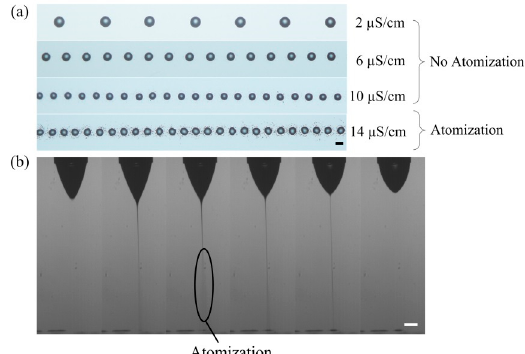
Figure 4. The atomization in e-jet printing: ( a ) the image of printed droplets on a silicon wafer; ( b ) the jetting process for liquid with a conductivity of 14 µS/cm. The time interval between adjacent images was 143 µs. The viscosity of the liquids was 60 mPa·s. The applied voltage was 2150 V. The nozzle-to-substrate distance was 1.5 mm. The moving speed of the substrate was 20 mm/s. Scale bar represents 100 µm.